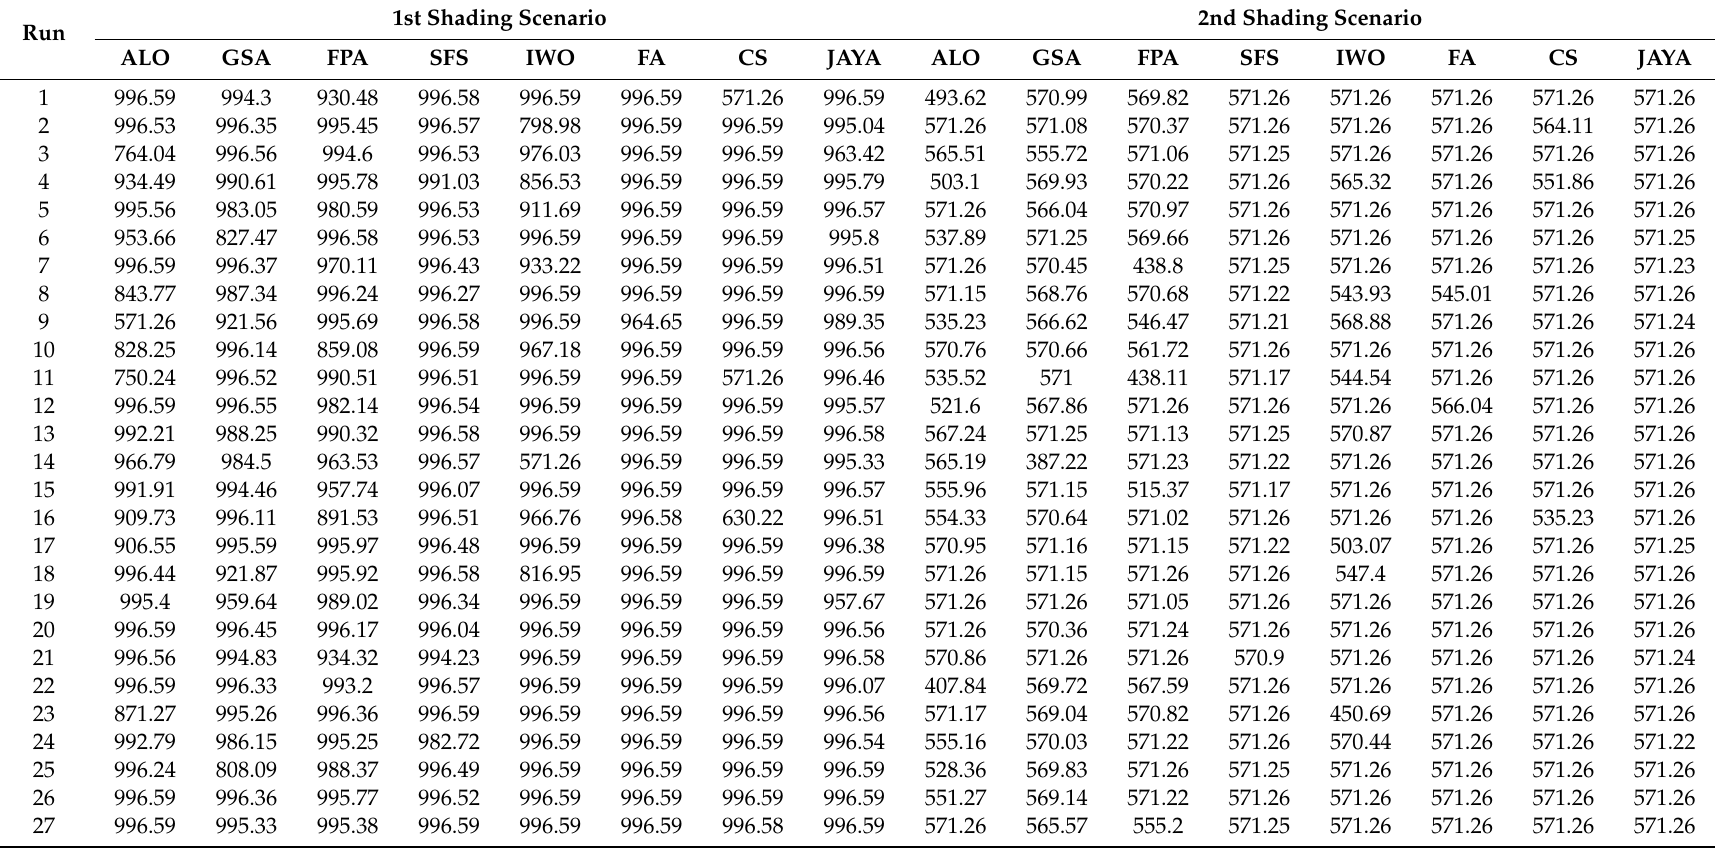
Table A1. The detailed performance of each optimizer for the 1st and 2nd shading